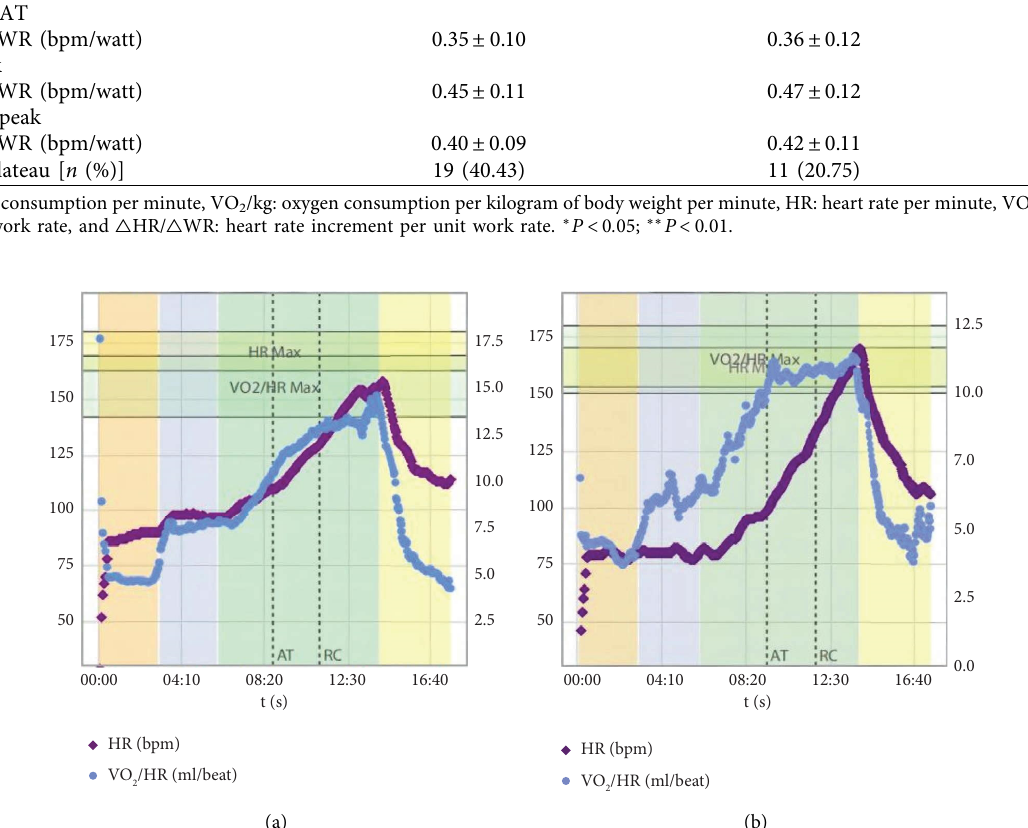
2 /HR plateau and